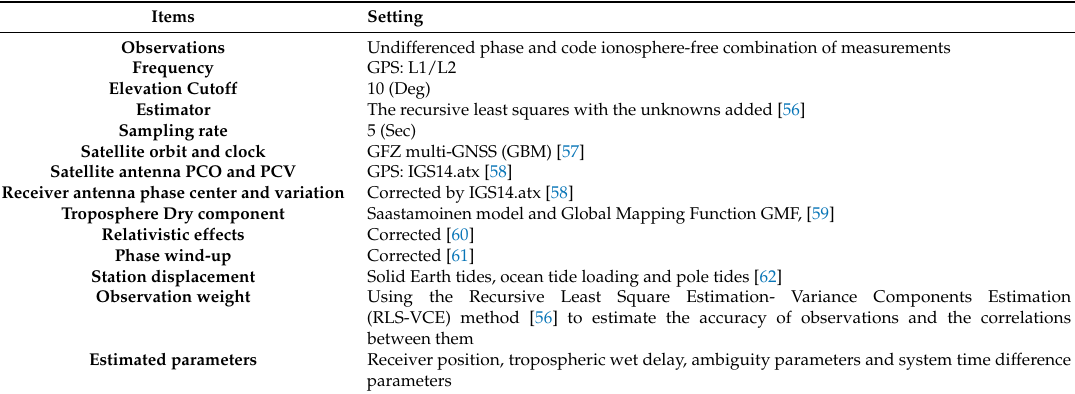
Table 2. An overview of the observations, models and processing strategy used for the precise Point Positioning (PPP) experiment of this